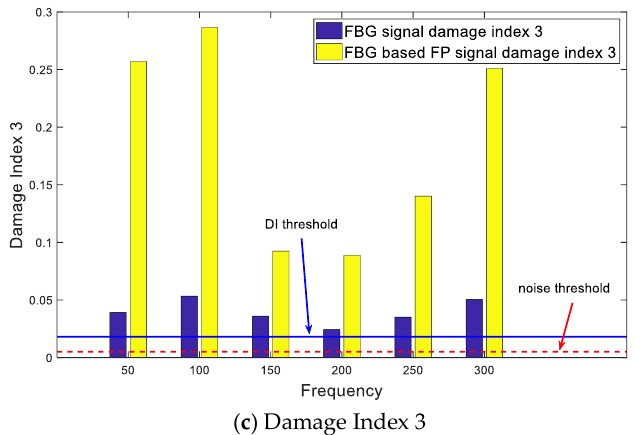
Figure 20. Different damage indices at various frequencies for damage detection. Figure 20. Di ff erent damage indices at various frequencies for damage